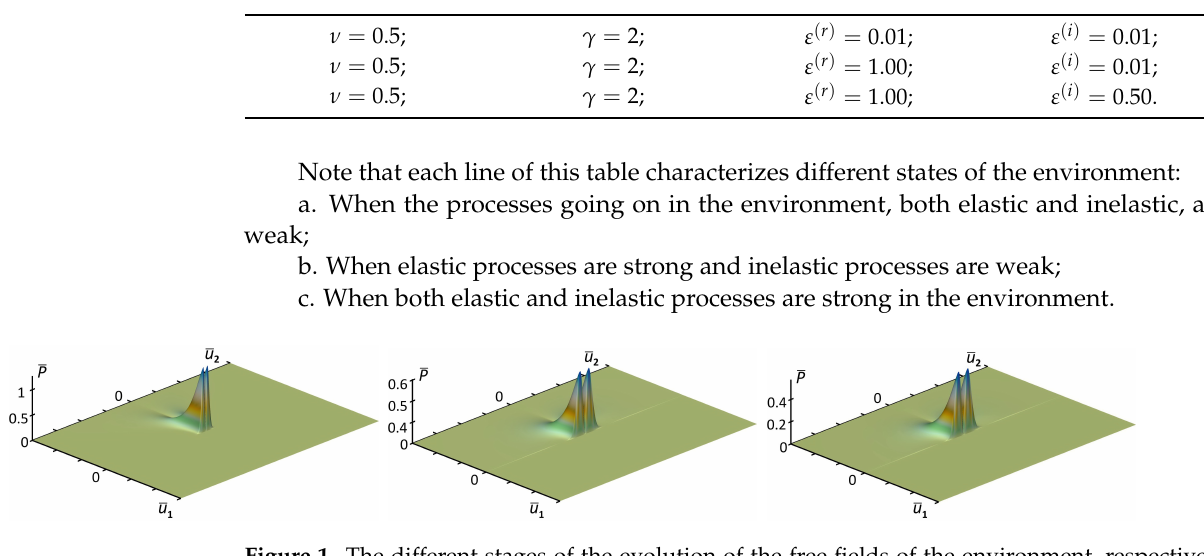
Table 1. Initial data required for problem modeling.